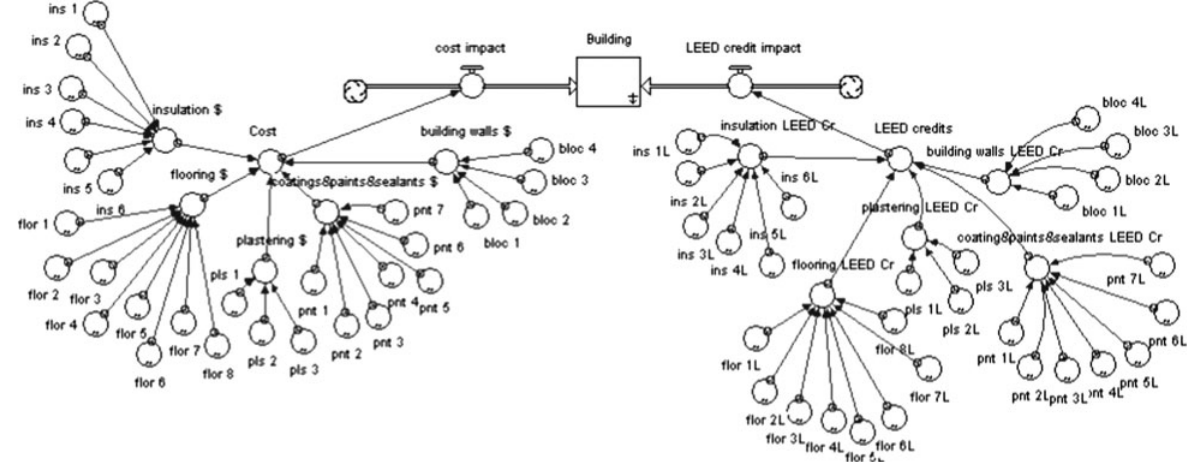
Fig. 1. Mapping model